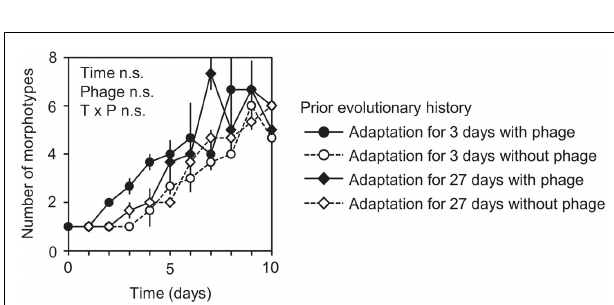
FIGURE 4 |Temporal change in total number of morphotypes after the competitor genotype was introduced on day 0 and the focal genotype on day 1. Data show mean number of morphotypes (those derived from focal and competitor genotypes combined) ± SEM ( n = 3).Two-way ANOVA results are indicated as in Figure 1 (see Table 5